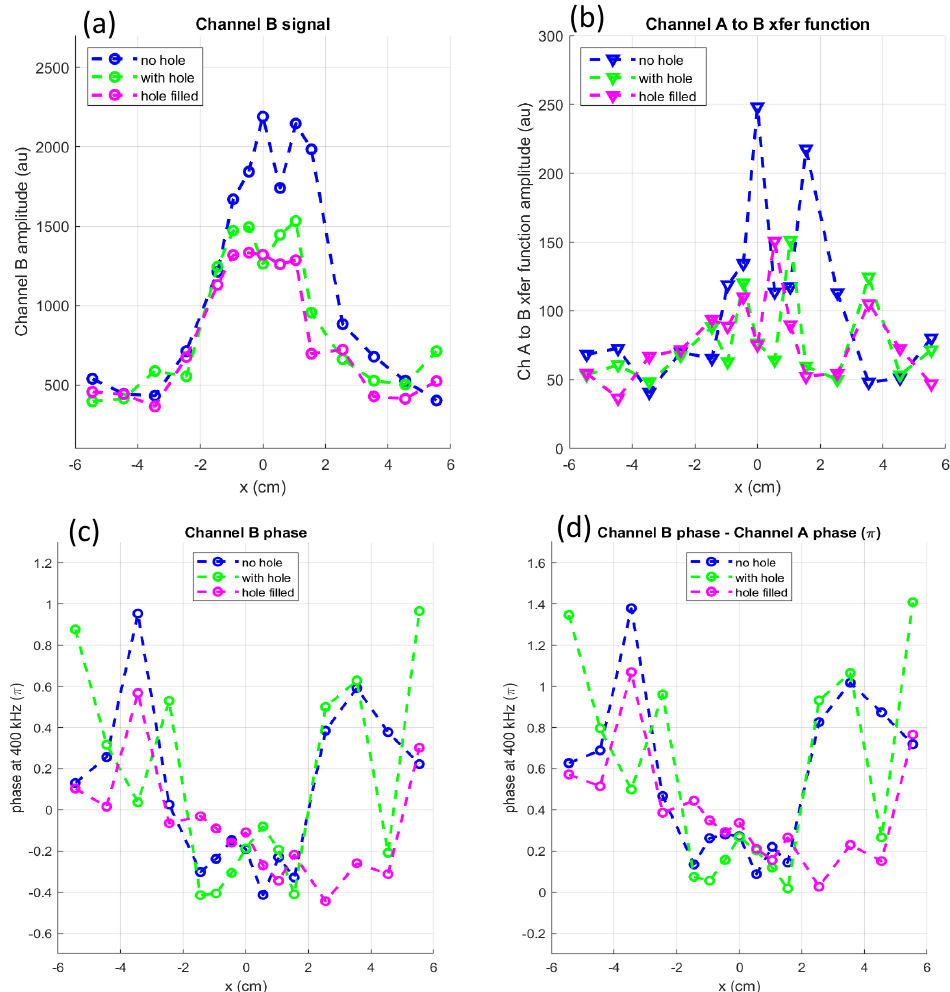
Figure 14. Amplitude of ( a ) sensor signal and ( b ) driving-voltage-to-sensor-signal transfer function, and phase of ( c ) sensor signal and ( d ) of driving-voltage-to-sensor-signal transfer